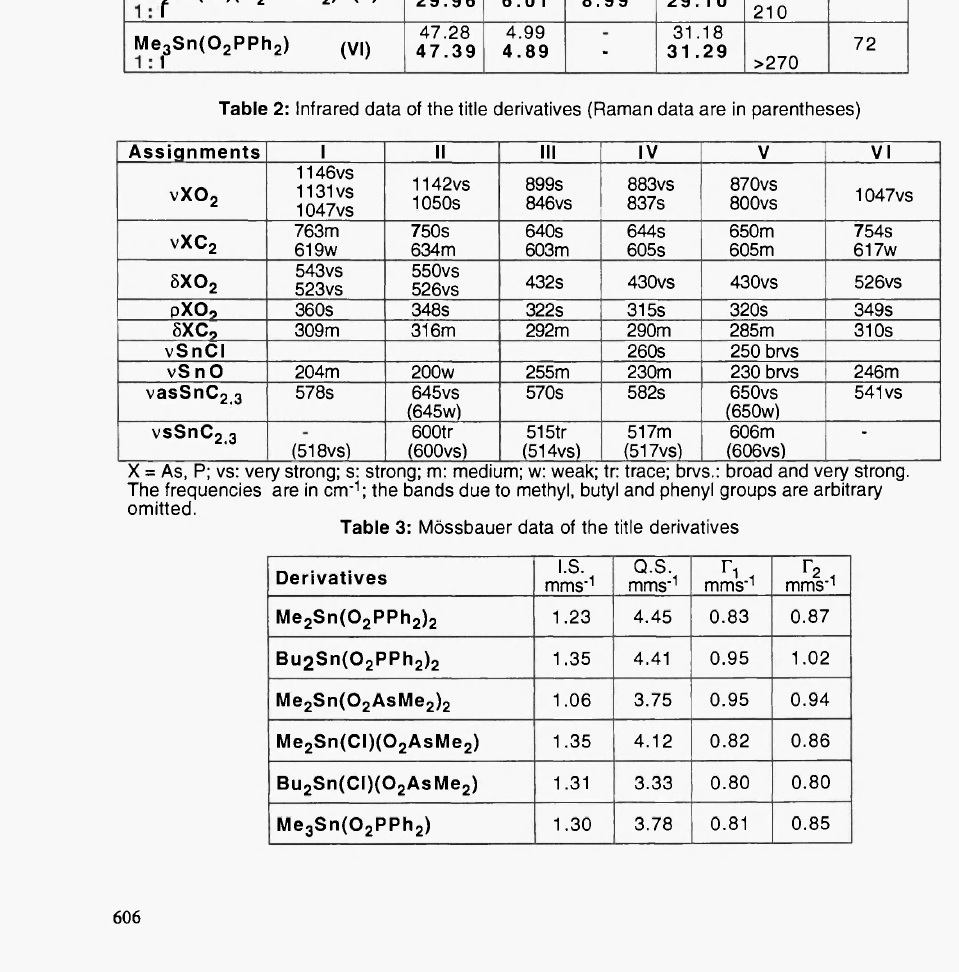
Table 2: Infrared data of the title derivatives (Raman data are in parentheses) Assignments